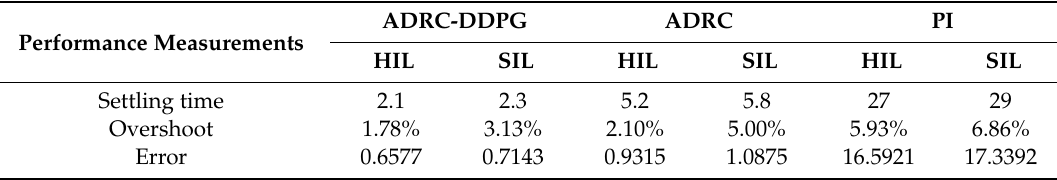
Table 1. Settling time, overshoot and output error comparison outcomes according to the scenario I. Performance Measurements